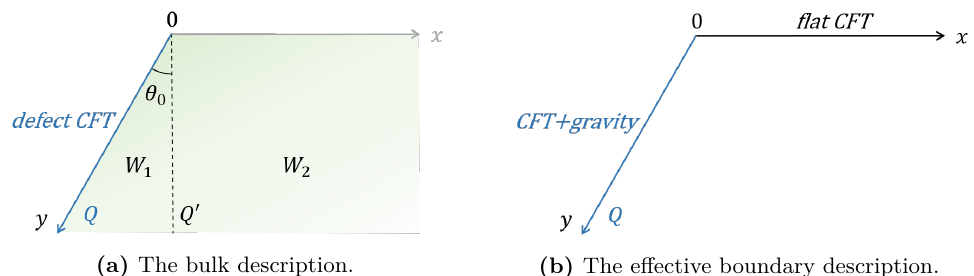
Figure 3. (a) The bulk geometry is an AdS 3 bulk with an EOW brane on which there is a defect CFT. The imaginary boundary Q 0 (dotted line) divides the bulk into two parts, W 1 and W 2 . (b) The boundary description consists of a flat CFT gluing to a CFT coupled to gravity. This 2 d effective theory is obtained by applying partial Randall-Sundrum reduction and AdS/CFT correspondence to W 1 and W 2